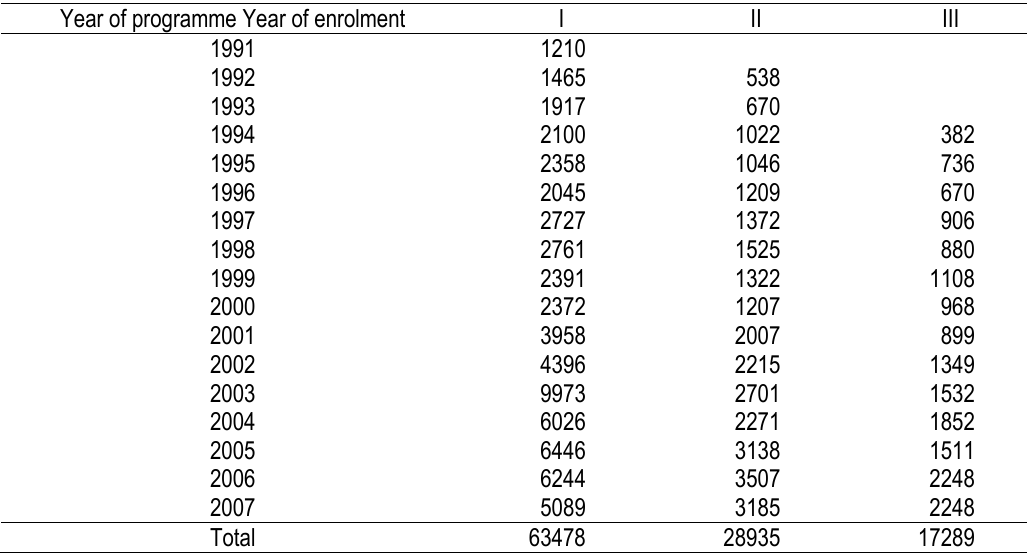
Table 3. Learner Enrolment in Different Levels a. B.Sc. Programme of